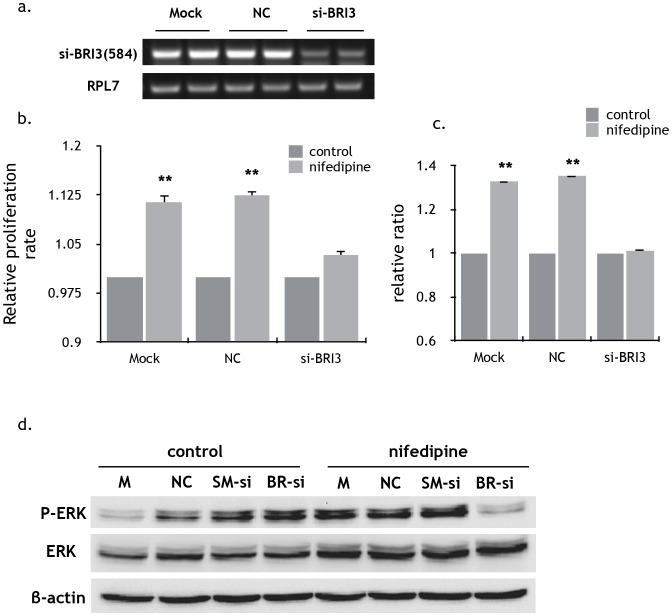
Inhibition of proliferation, migration and P-Erk of MDA-MB-231 by silencing BRI3 gene expression.a) Effective silencing of BRI3 mRNA in MDA-MB-231 cells after siRNA treatment. BRI3-homo-584 siRNA markedly inhibited BRI3 mRNA expression at 100 nM after transfection for 24h. b) siRNA directed against BRI3 suppressed the facilitation of nifedipine in the proliferation of MDA-MB-231 cells. Data were presented as the mean±SEM of three independent experiments. Specific comparison between nifedipine groups and control groups, P<0.01, 1-way ANOVA. c) MDA-MB-231 cells transfected with mock, si-BRI3 and negative control were plated in the upper chamber of transwell. Data were presented as the mean ± SEM of three independent experiments. Specific comparison between nifedipine groups and control groups, P<0.01, 1-way ANOVA. d) Increased protein expression of P-Erk in MDA-MB-231 cell lines treated with nifedipine was inhibited 72h after transfection of BRI3-siRNA. M means mock, NC means negative control, SM-si means si-SMOC1 gene, BR-si means si-BRI3 gene.